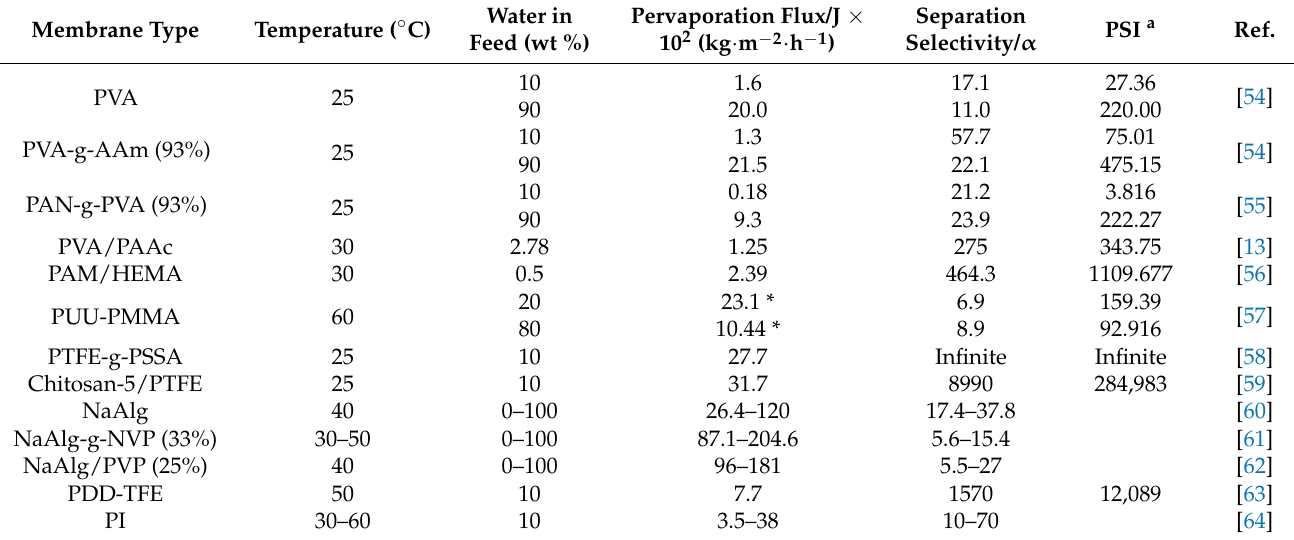
Table 2. Comparison of parameters of different polymeric membranes in DMF